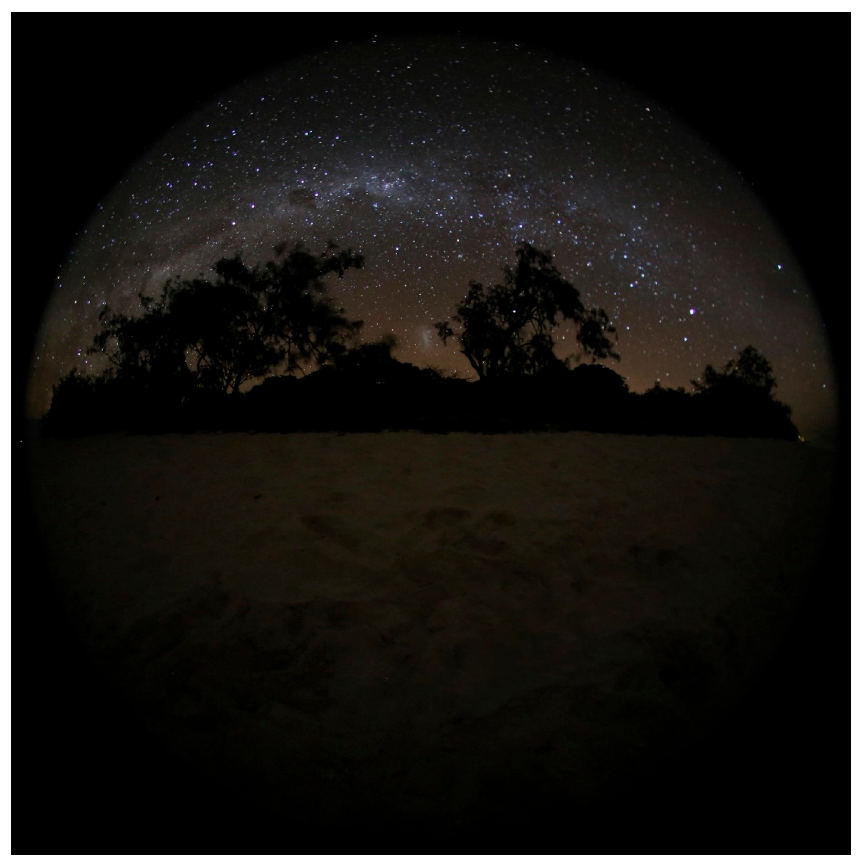
Figure 12. Landward photograph taken on the night of 10 May 2018 at sampling site 19 Heron Island, Australia. This photograph clearly demonstrates the contrasting brighter celestial lit sky with the darker vegetative obstruction/silhouettes. Remote Sens. 2020 , 12 , x FOR PEER REVIEW